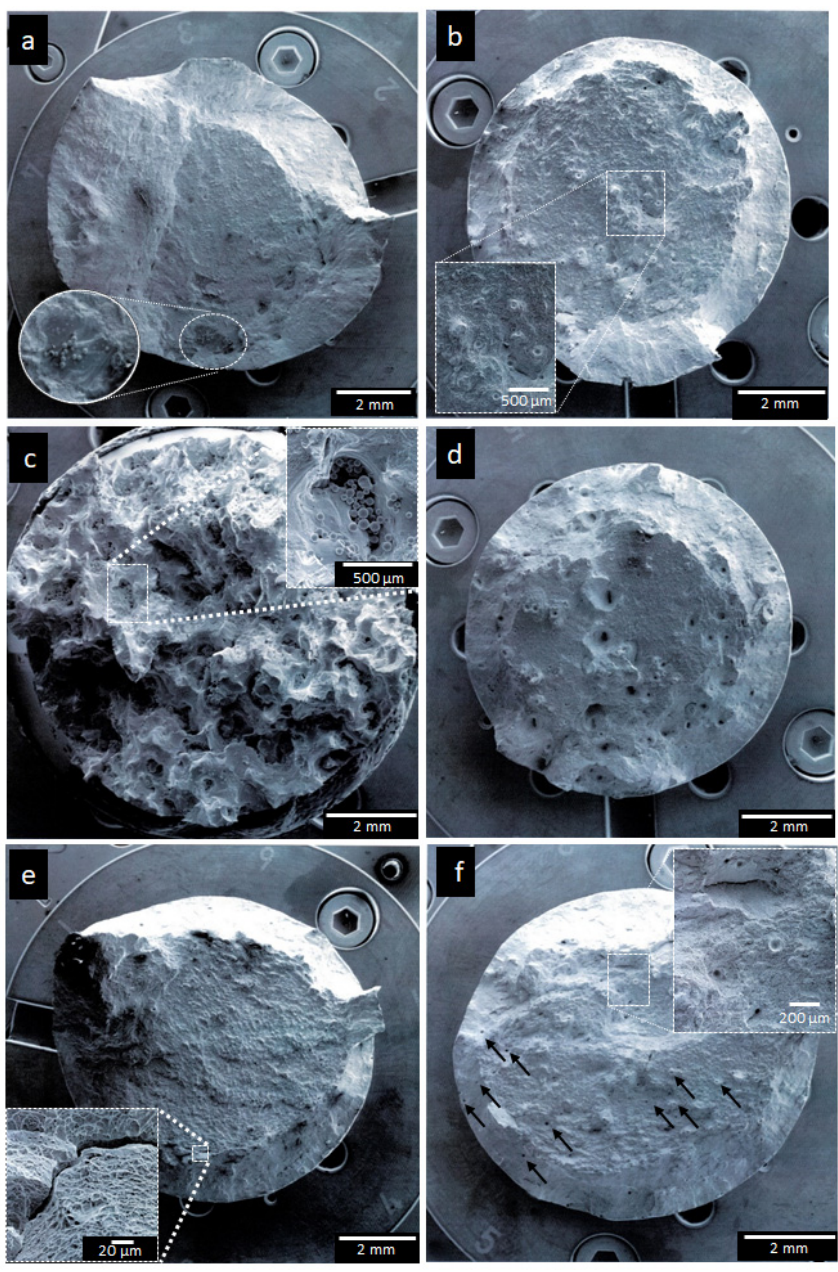
Figure 6. SEM tensile fracture surfaces of samples 1 ( a ), 2 ( b ), 3 ( c ), 4 ( d ), 5 ( e ), and 9 ( f ). Fractography reveals that all samples have a certain amount of pores. Their quantity and distribution vary within the samples, which affects the fracture mechanism.